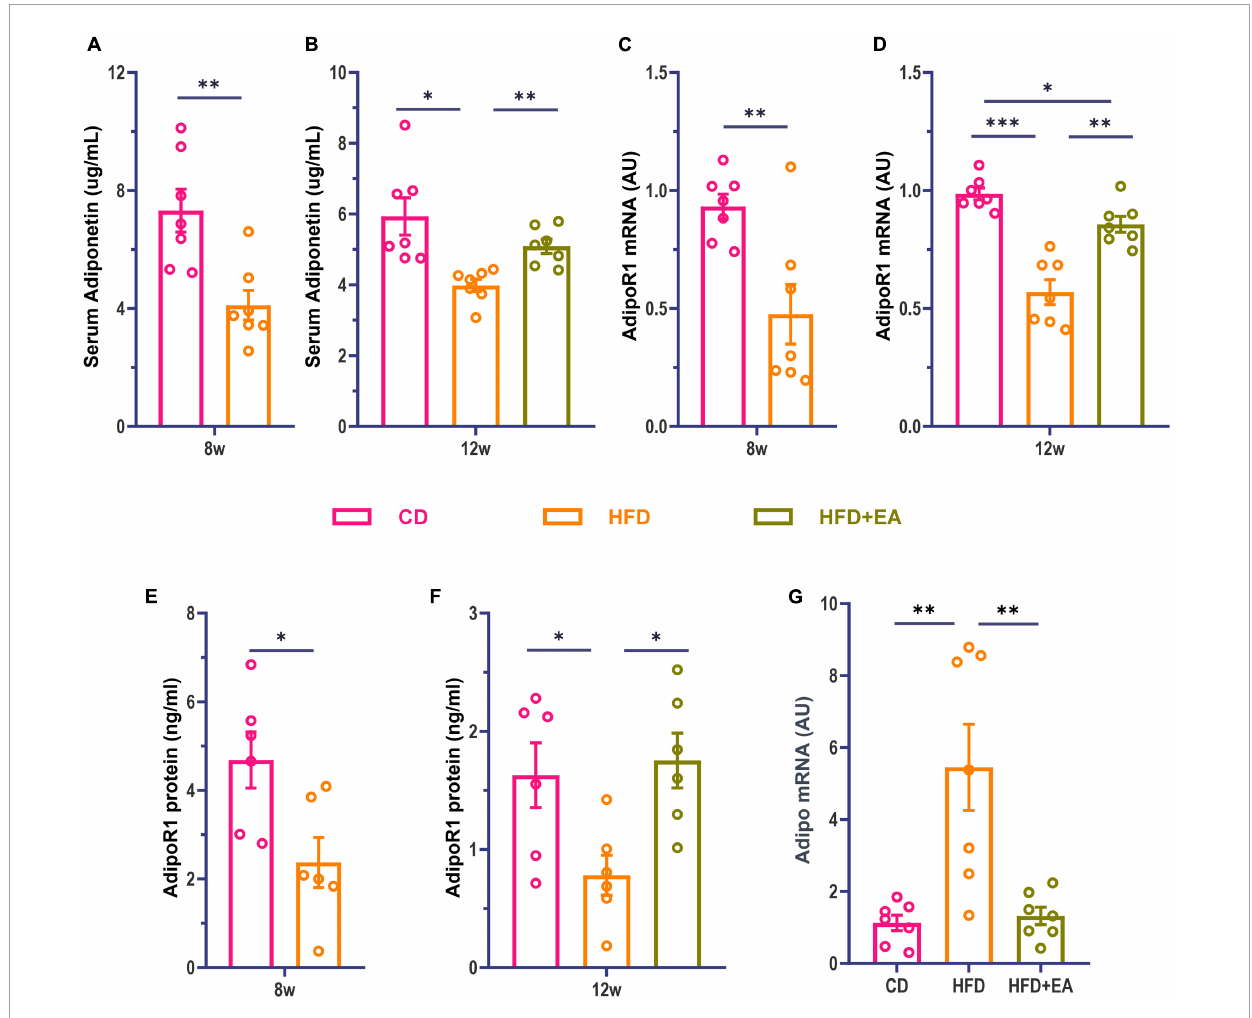
FIGURE2 HFD + EA mice exhibited improved levels of Adipo and AdipoR1. (A) Serum Adipo concentration of mice after HFD modeling. (B) Serum Adipo concentration of mice after EA. (C) Expression of AdipoR1 mRNA in skeletal muscle of mice after HFD modeling. (D) Expression of AdipoR1 mRNA in skeletal muscle of mice after EA. (E) AdipoR1 protein concentration in skeletal muscle of mice after HFD modeling. (F) AdipoR1 protein concentration in skeletal muscle of mice after EA. (G) Expression of Adipo mRNA in skeletal muscle of mice after EA. CD: control group. HFD: high-fat diet group. HFD + EA: model + electroacupuncture group. ns P > 0.05; ∗ P < 0.05; ∗∗ P < 0.01; ∗∗∗ P < 0.001 [unpaired t -test in panels (A,C,E) ; one-way analysis of variance with post hoc Bonferroni correction or Tamhane correction in panels (B,D,F,G)